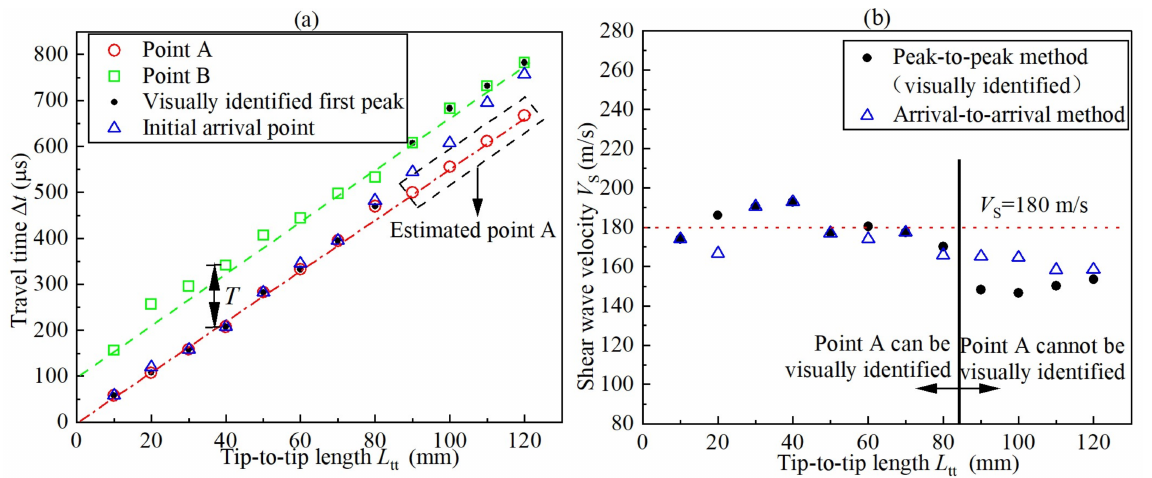
Figure 5. Results of ( a ) travel time ∆ t and ( b ) S-wave velocity V S ( f = 5